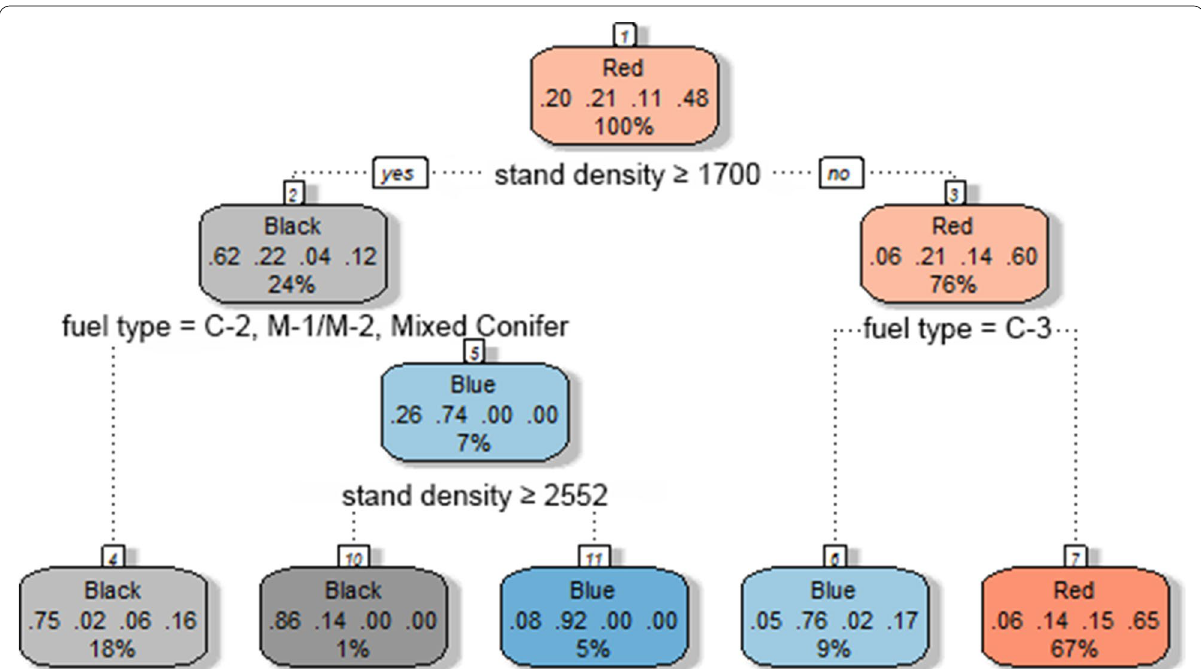
Fig. 7 A classification tree with a depth of three that predicts a stand’s fuel class cluster (FCC) membership. Percentages within each box represent the percentage of the data belonging to that section of the tree. The four decimal values within each box represent the proportion of the data at that point of the tree belonging to each of the four FCCs. From left to right, the proportions are shown for the Black, Blue, Green, and Red FCC. Stand density is trees per hectare of live conifers in the canopy. Fuel type is the Canadian Forest Fire Behaviour Prediction (FBP) System fuel type assigned to the stand